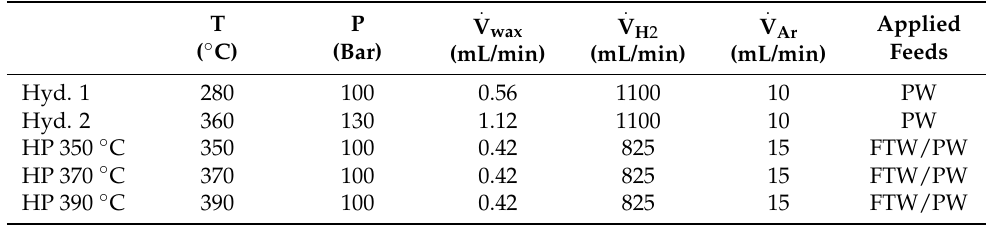
Table 3. Process parameters for hydroprocessing experiments in the fixed-bed reactor. Gas flows are given at laboratory